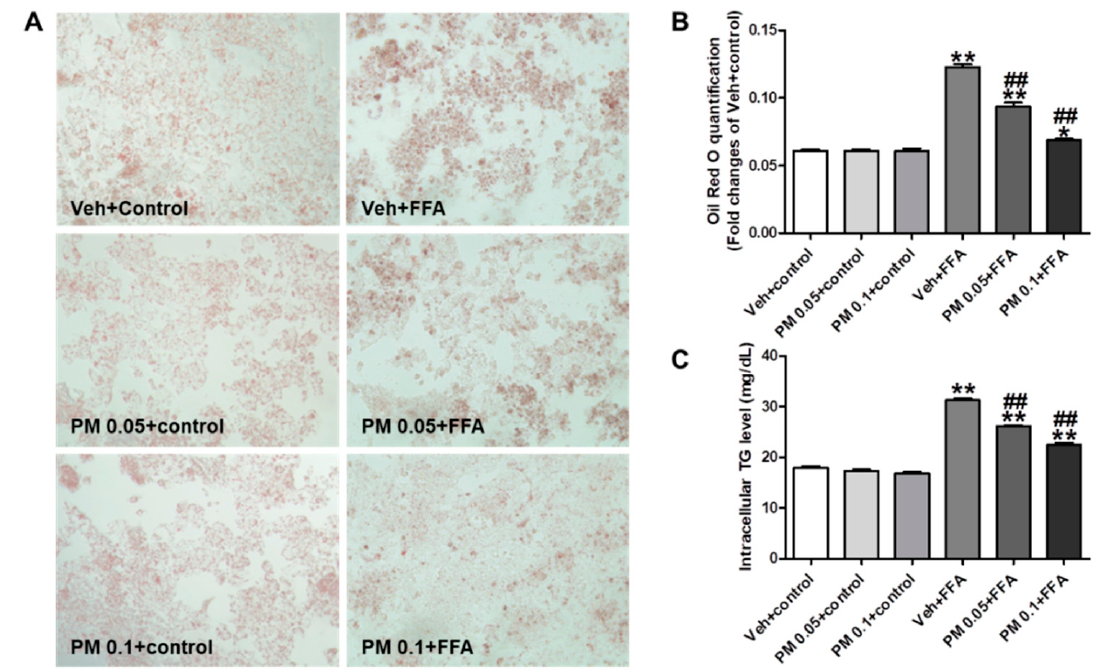
Figure 2. The effect of PM on intracellular lipid and triglyceride (TG) accumulation in free fatty acid (FFA)-treated HepG2 cells. Representative pictures (magnification 200X) of Oil-red O stain in HepG2 cells from three independent experiments ( A ), the quantification of lipid contents ( B ), and intracellular TG levels ( C ) were shown. Control groups were treated with 1% of fatty acid-free bovine serum albumin (BSA), and FFA groups were treated with 1 mM of FFA for 24 h, and then were harvested. PM was pre-treated 1 h prior to FFA at the indicated concentrations. Data are the mean ± SEM. ** p < 0.01 vs. Veh + control group; ## p < 0.01 vs. Veh + FFA group.